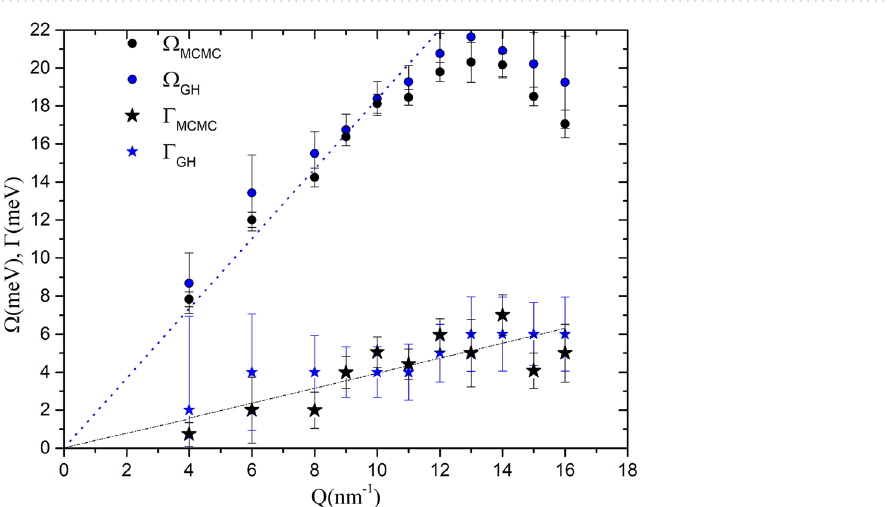
Figure 4. Q dependence of the undamped frequency (cid:31) (circles) and the damping Ŵ (stars) of the longitudinal mode obtained from the fits to the dynamics structure factor by means of the GH model (blue simbols) and the MCMC algorithm (black symbols). The hydrodynamic behaviour for liquid silver (sound speed also shown (blue dotted line). The linear black dotted line is only a guide for the